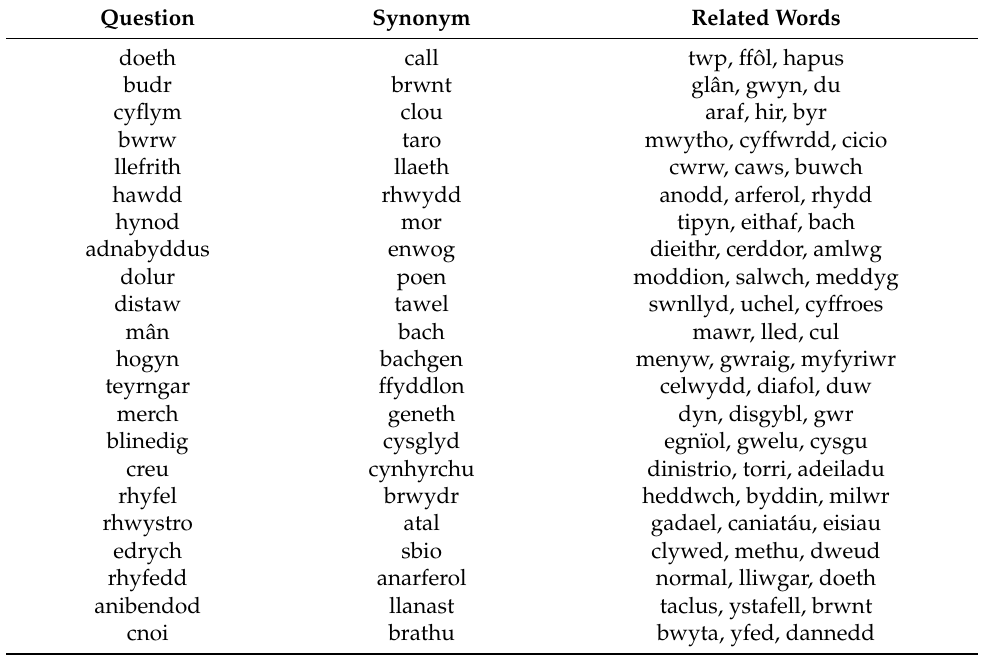
Table A2. Synonym detection